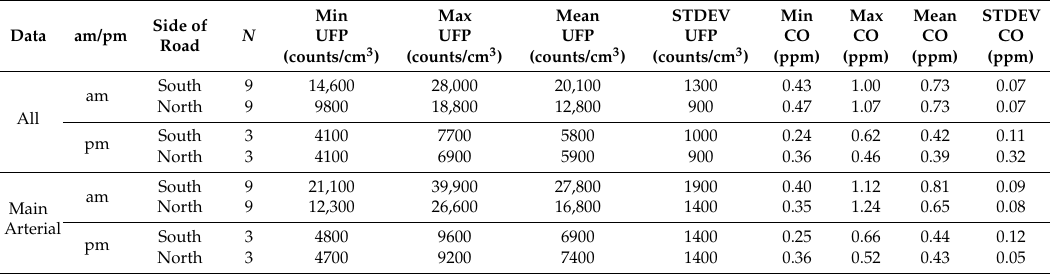
Table 3. Descriptive statistics for air pollution exposures on walking journeys. ‘All’ represents the complete route while ‘Main Arterial’ is restricted to observations made when travelling on the main arterial road segment.